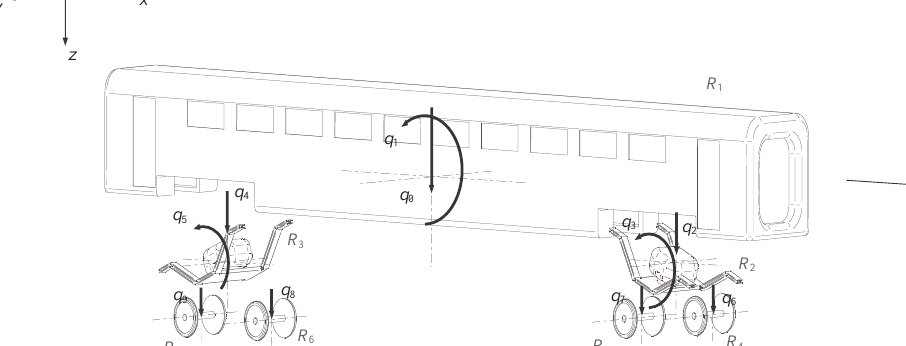
Figure 6. Vehicle modelling – kinematics in the xz -plane.